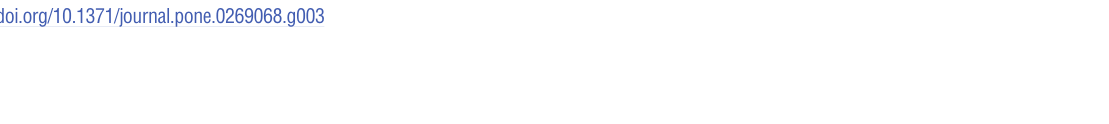
PLOS ONE | https://doi.org/10.1371/journal.pone.0269068 September 1,